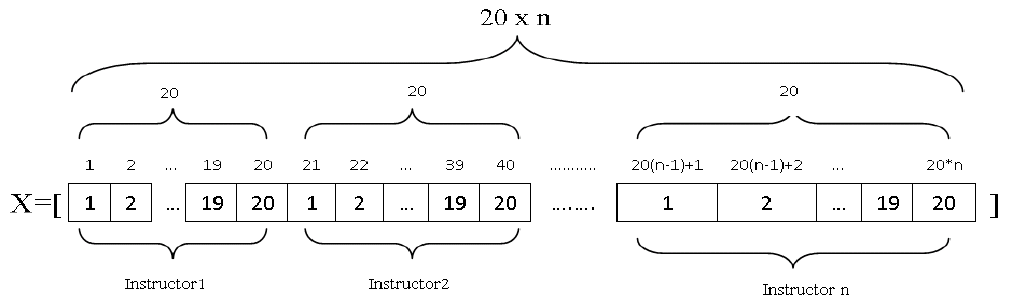
Figure 2. Particle encoding